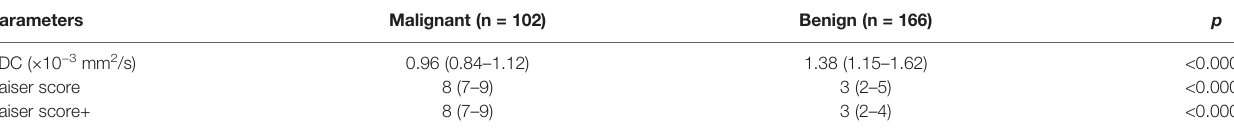
TABLE 3 | Comparison of different parameters between benign and malignant lesions. Parameters